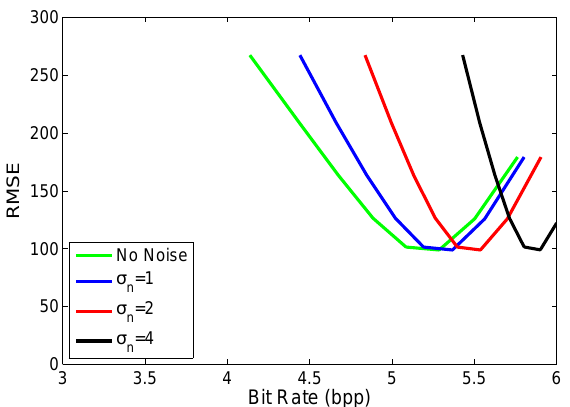
Figure 13. RMSE versus BR by varying K min and σ n , for the Yellowstone scene 0 in the BSQ